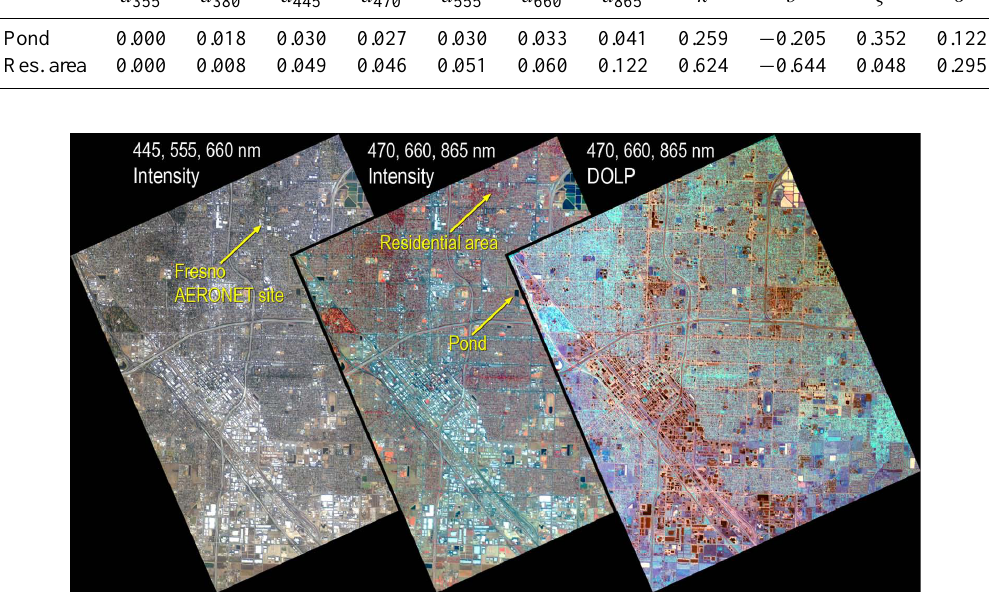
Fig. 13. AirMSPI nadir imagery of Fresno, CA, acquired on 6 January 2012. The left and middle images are intensity data using different spectral band combinations. The right image displays DOLP in the three polarimetric bands. The images have been contrast enhanced to highlight details. The locations of the Fresno AERONET site, the pond, and the residential area are